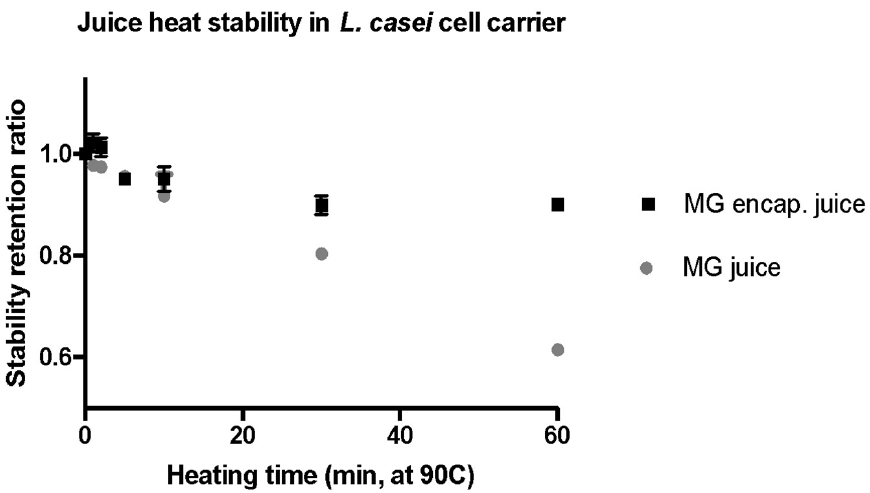
Figure 5. Stability of juice pigments with and without encapsulation under heat treatment. After treatment, the MG juice was extracted with 85% methanol and quantified using UV-Vis measurements at 530 nm.